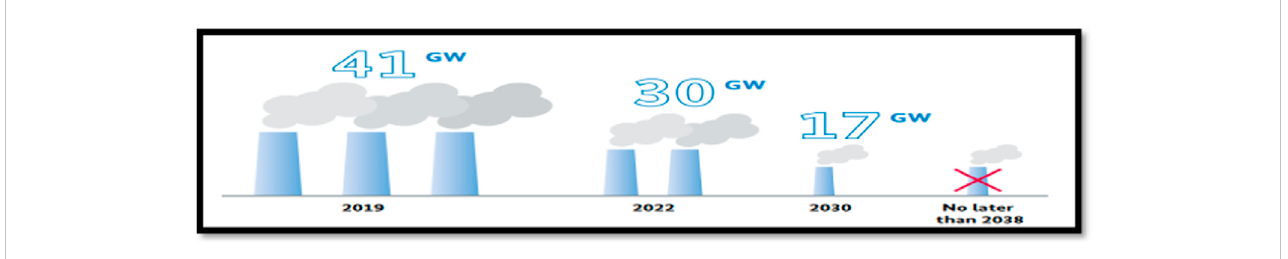
FIGURE 5 Schedule for coal phase-out in Germany. Source: BMWi